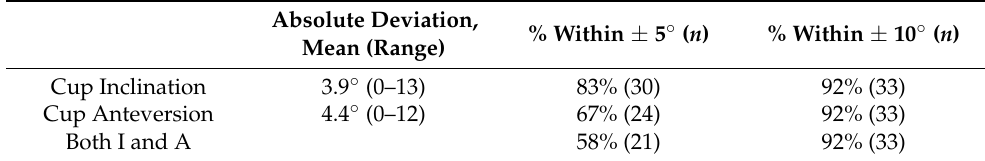
Table 2. Deviation from the planned cup values.